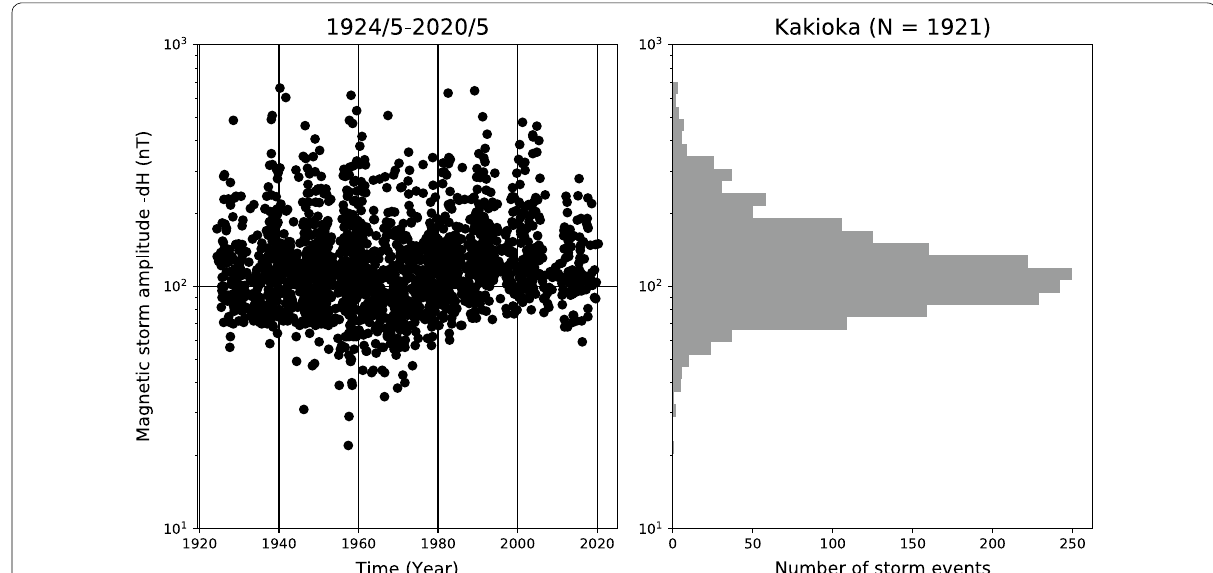
Fig. 1 Magnetic storm events observed at Kakioka Magnetic Observatory for 96-year time interval from May 1924 to May 2020. The histogram is also shown at right-hand